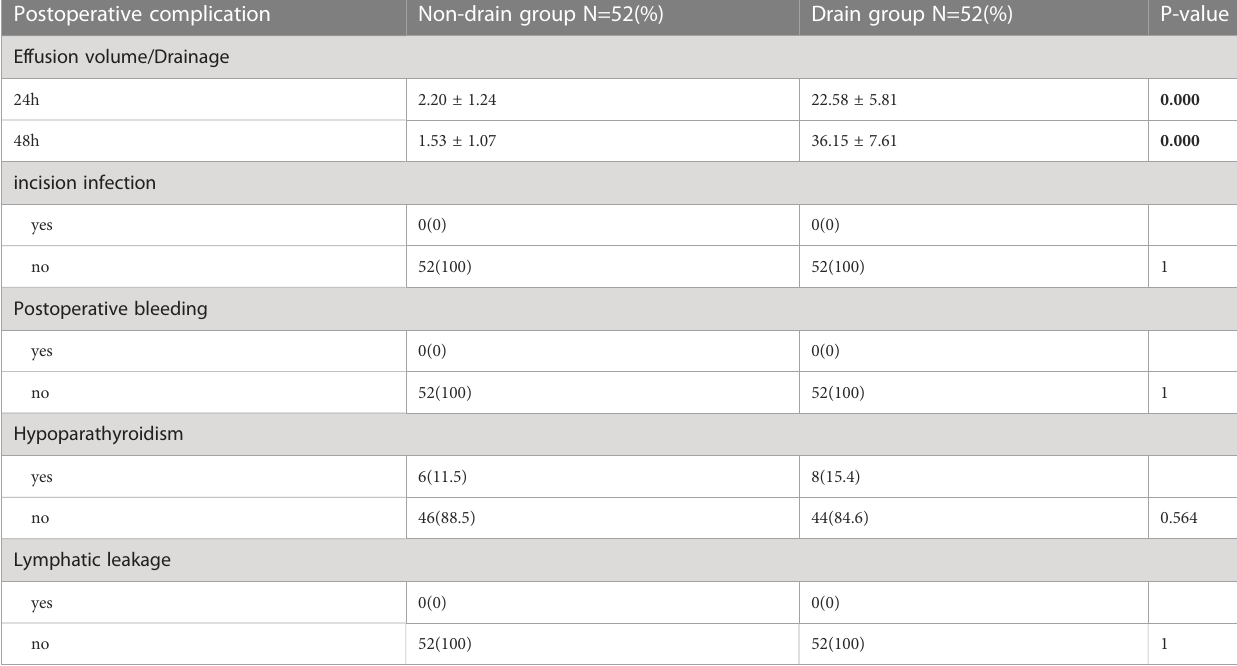
TABLE 2 Comparison of postoperative complication between the non-drainage group and drainage group.